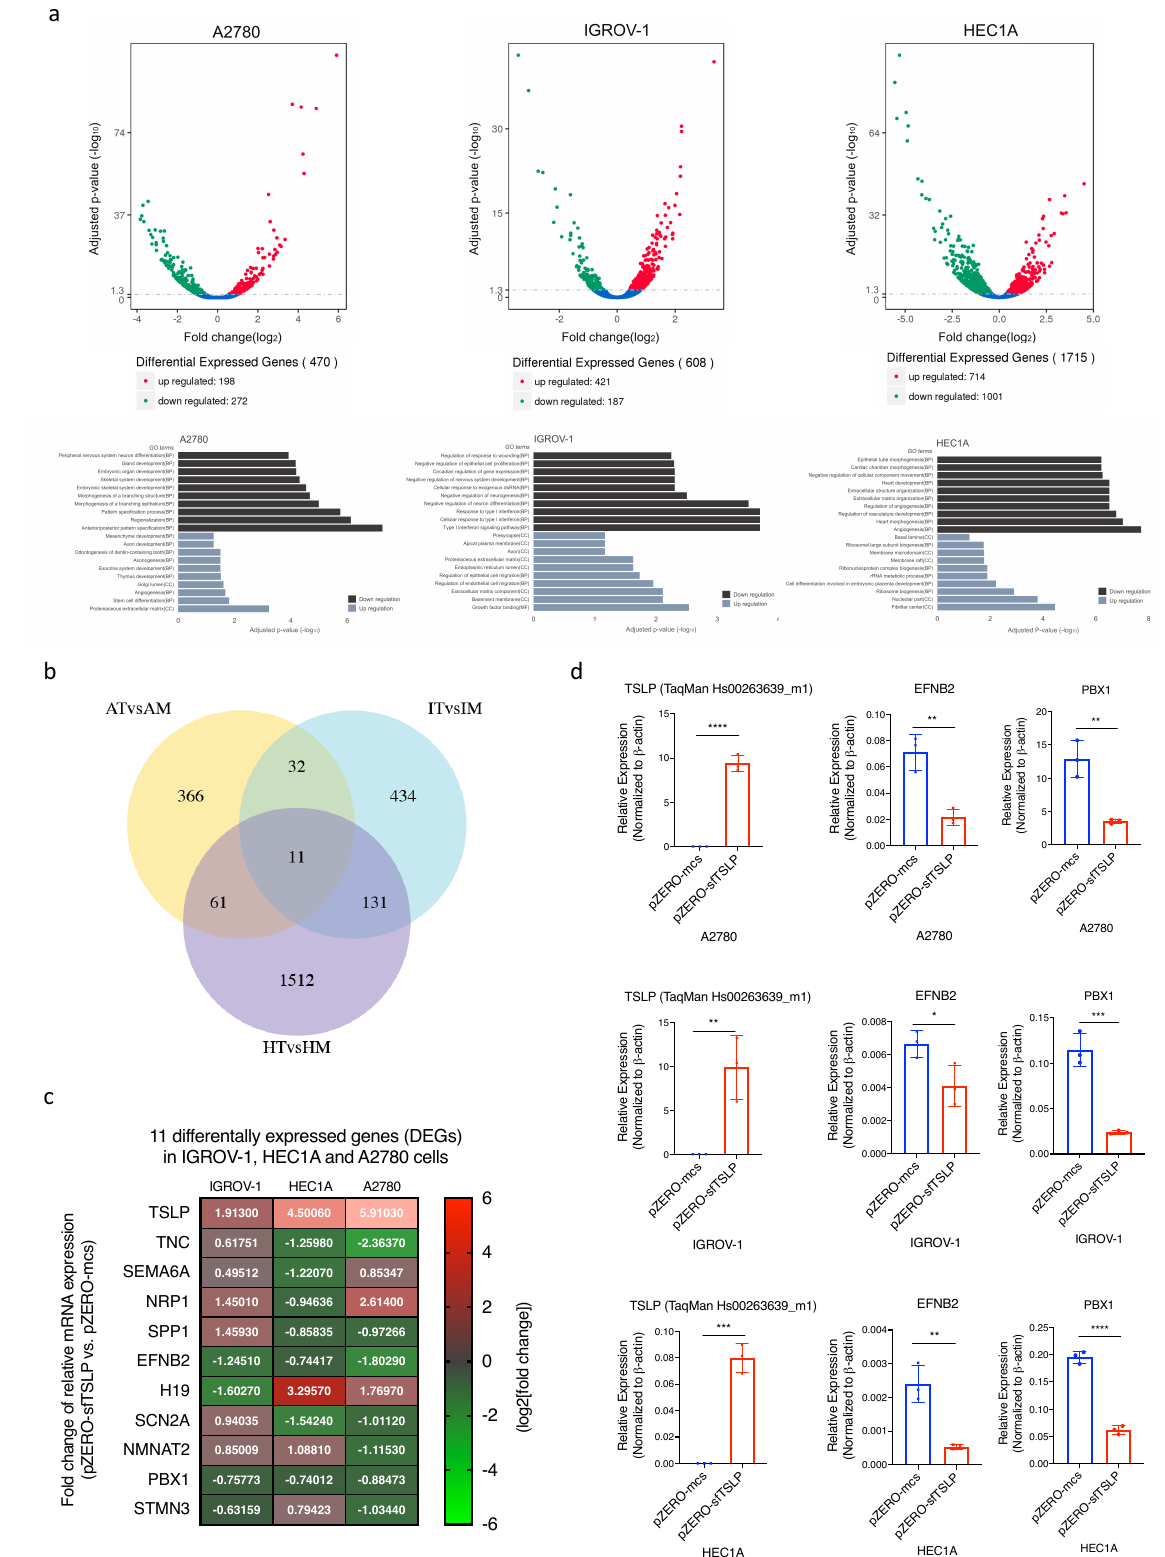
Figure 6. EFNB2 and PBX1 were commonly downregulated in human gynaecologic cancer cells with sfTSLP overexpression. ( a ) The volcano plot showed the upregulated (red dots) and downregulated (green dots) differentially expressed genes (DEGs) of A2780 ovarian cancer cells with sfTSLP overexpression (left top); the top 10 gene ontology (GO) enrichment terms of upregulated DEGs (grey bars) and downregulated DEGs (black bars) were shown (left bottom). The upregulated